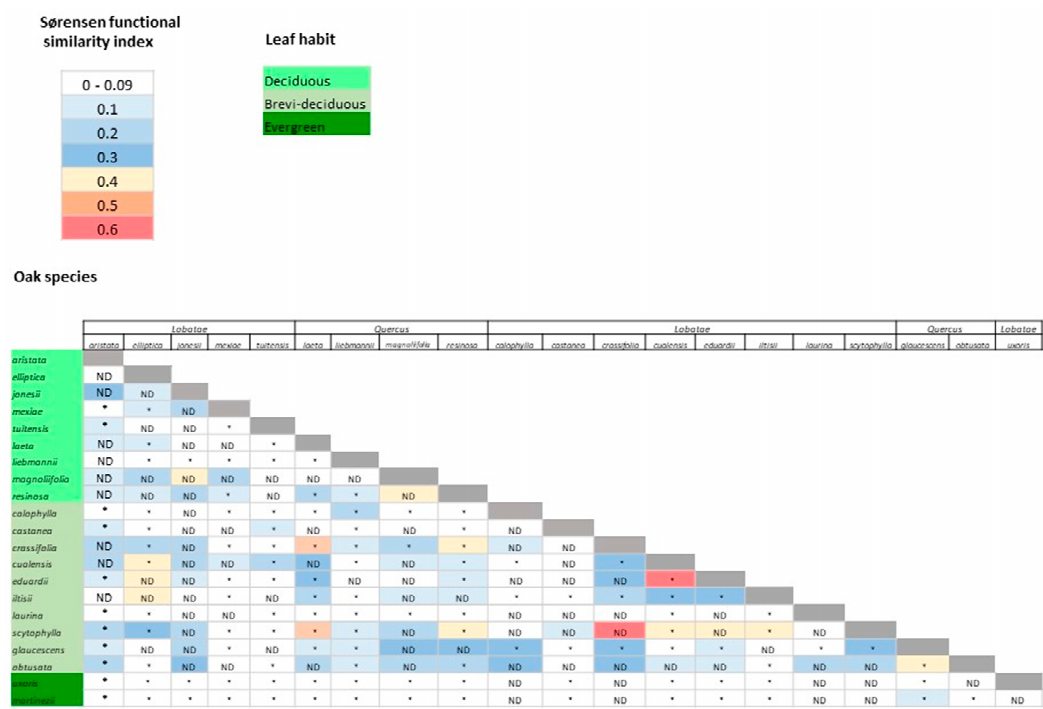
Figure A1. Sørensen Similarity Index among Oak Species